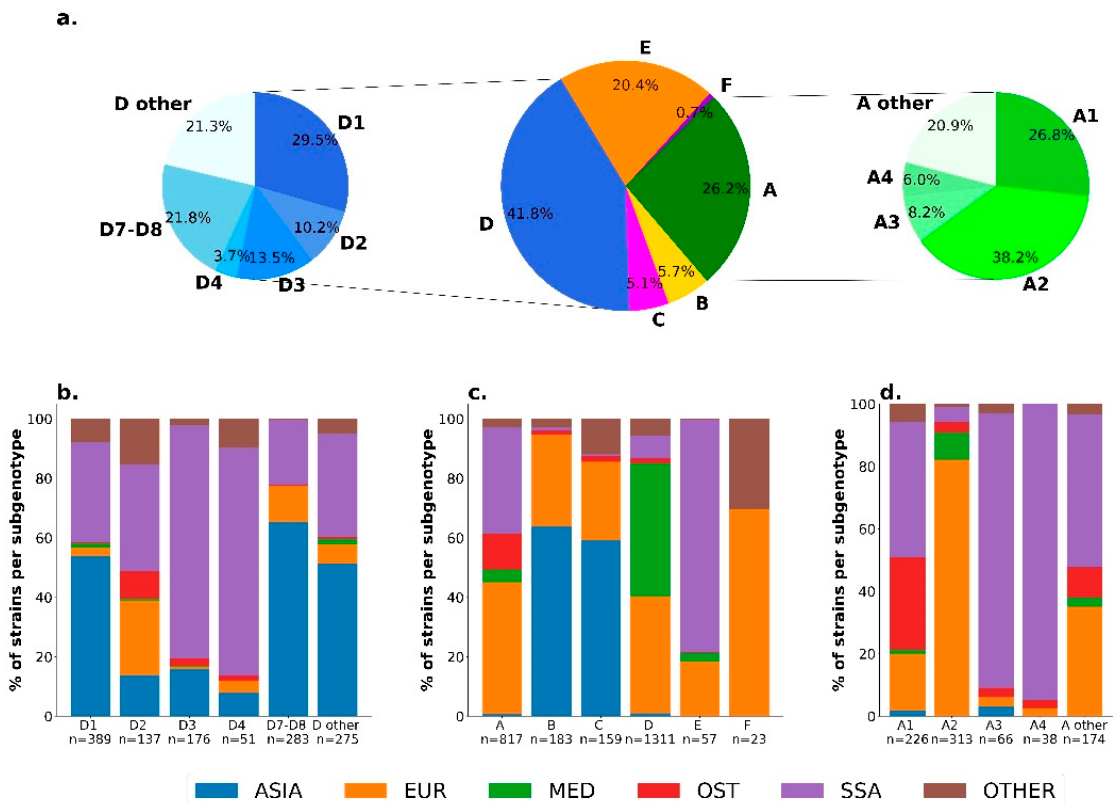
Figure 2. ( a ) Distribution of HBV genotypes, with genotypes A and D sub-genotypes in the total study population. The geographical origin of the donors is specified in ( b ) in the population infected by genotype D ( c ) in the total study population, and ( d ) in the population infected by genotype A. 3.3. Characterization of Donations according to HBV Markers (2005–2020) After NAT implementation, 30,977,753 donations were screened for HBV DNA be- down as follows: 2079 (94.1%) HBV DNA+/HBsAg+/anti-HBc+ (CHB), 81 (3.6%) HBV DNA+/HBsAg-/anti-HBc+ (OBI), 27 (1.2%) HBV DNA+/HBsAg+/anti-Hbc − (ABI),